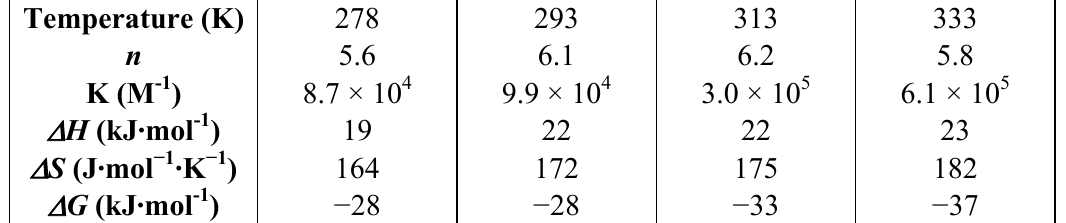
(CH CO ) (C H CO )} with LaCl at 142 3 2 5 2 5 2 3 (CH CO ) (C H CO ) was titrated with 10- μ L 3 mM 142 3 2 5 2 5 2 is 3